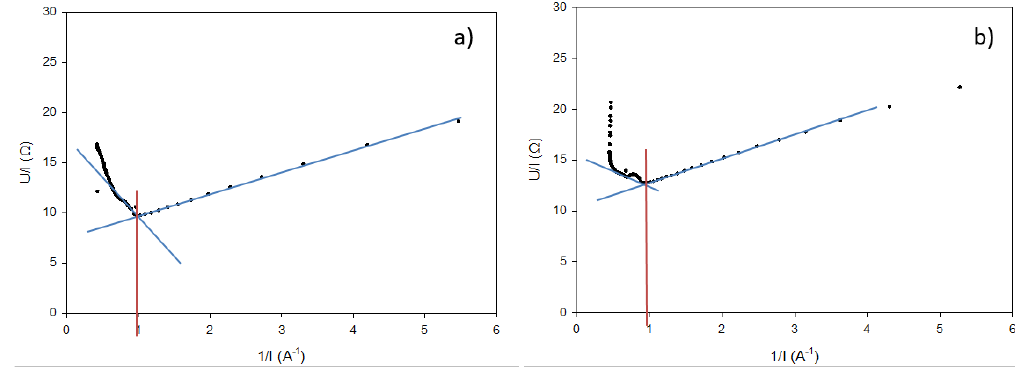
Figure 2. Determination of limiting current density (LCD) of ( a ) CACAC and ( b ) CNfCNfC membrane configuration.